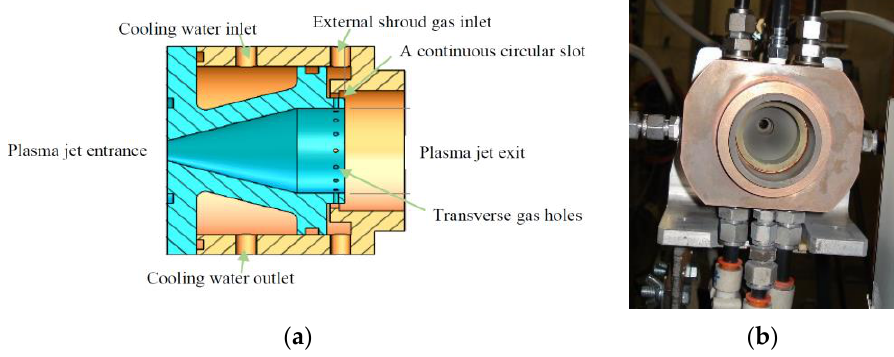
Figure 2. The shrouded plasma spraying of titanium coatings. ( a ) Schematic cross section of the shroud; ( b ) the experimental set-up of shrouded plasma spraying [24,25]. Table 2. The spraying parameters for the titanium coatings with and without the shroud. Spray Parameter Setting Current,